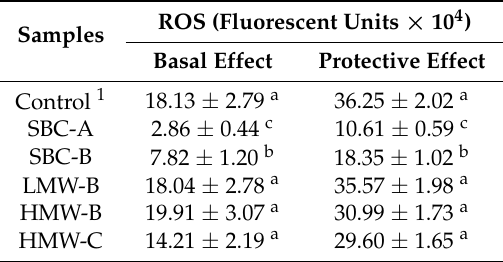
Table 4. Reactive oxygen species (ROS) generation in Caco-2 cells after 2 h incubation with the bioaccessible portion of bread crust (BC) or its different low and high MW